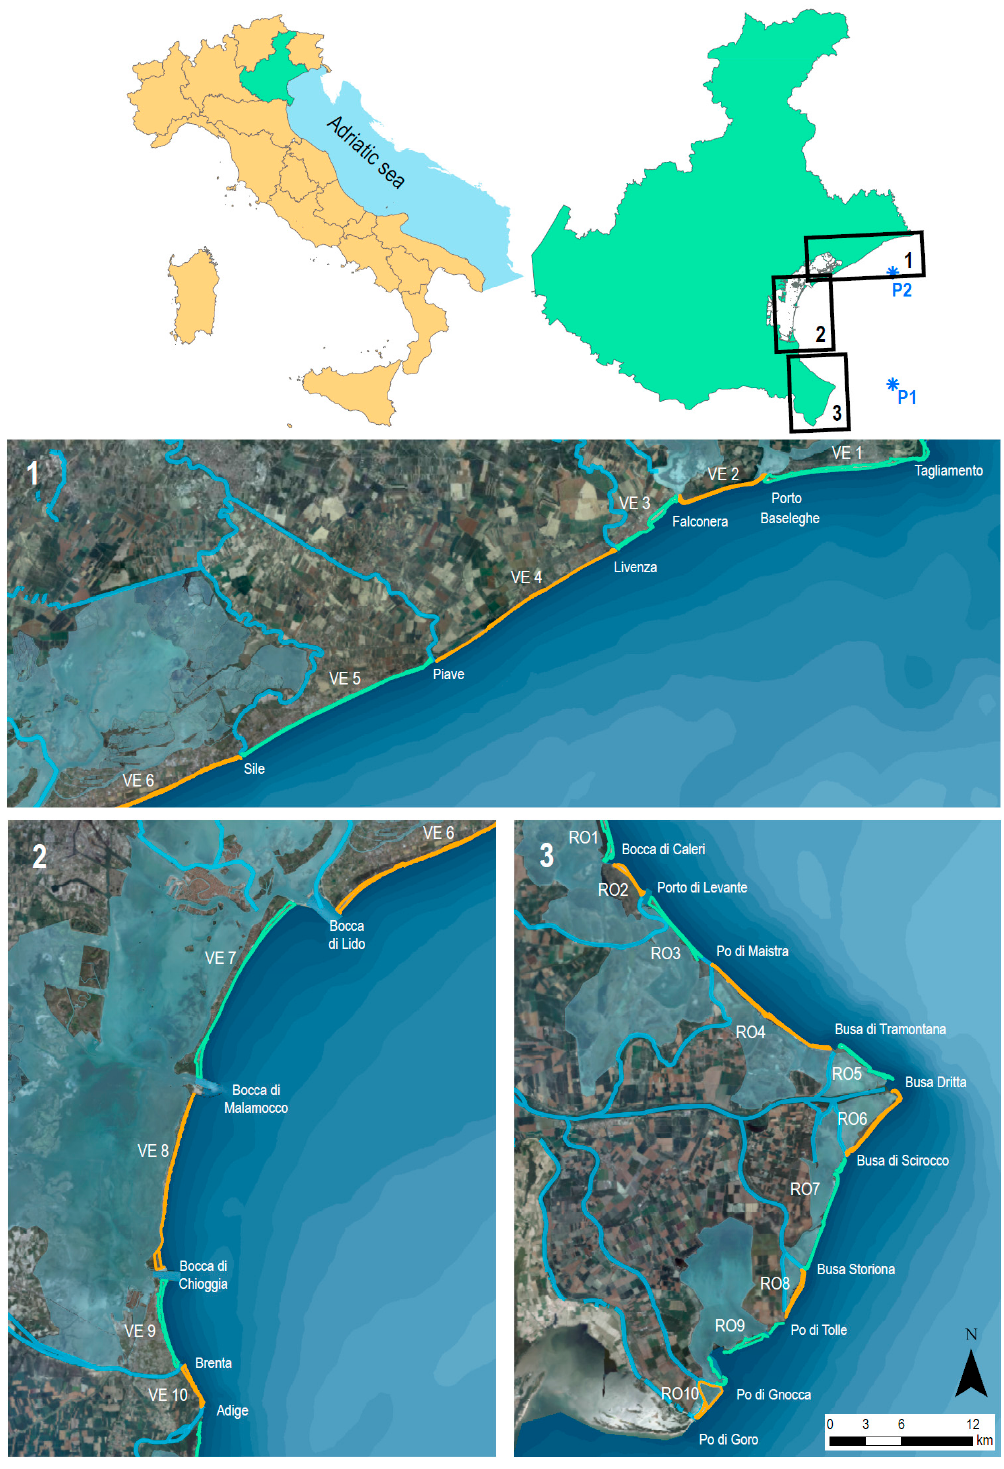
Figure 5. Venetian littoral and its subdivision into coastal cells.